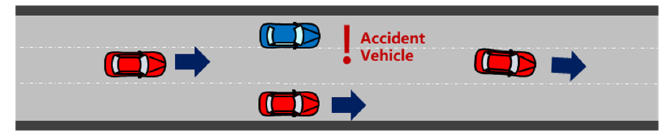
Figure 13. An example experiment scenario.